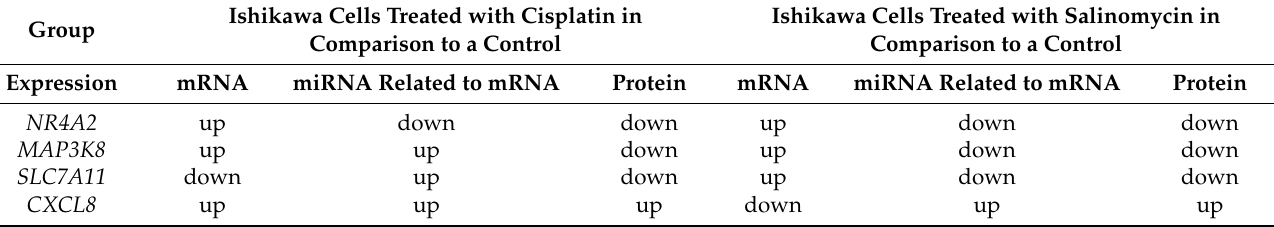
Table 6. Summarizing the changes in the expression of the selected